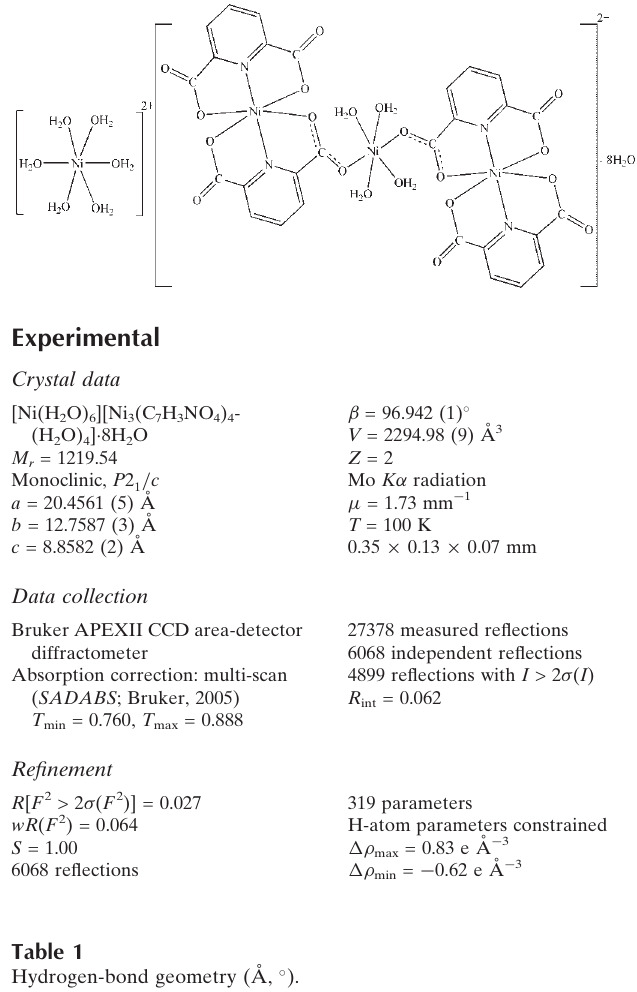
Hydrogen-bond geometry (A˚ , (cid:4)